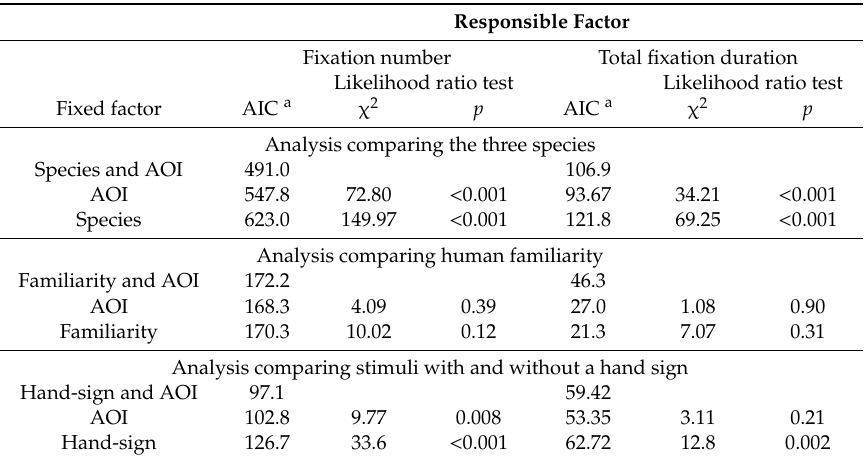
Table 2. Generalized Linear Mixed Model results.